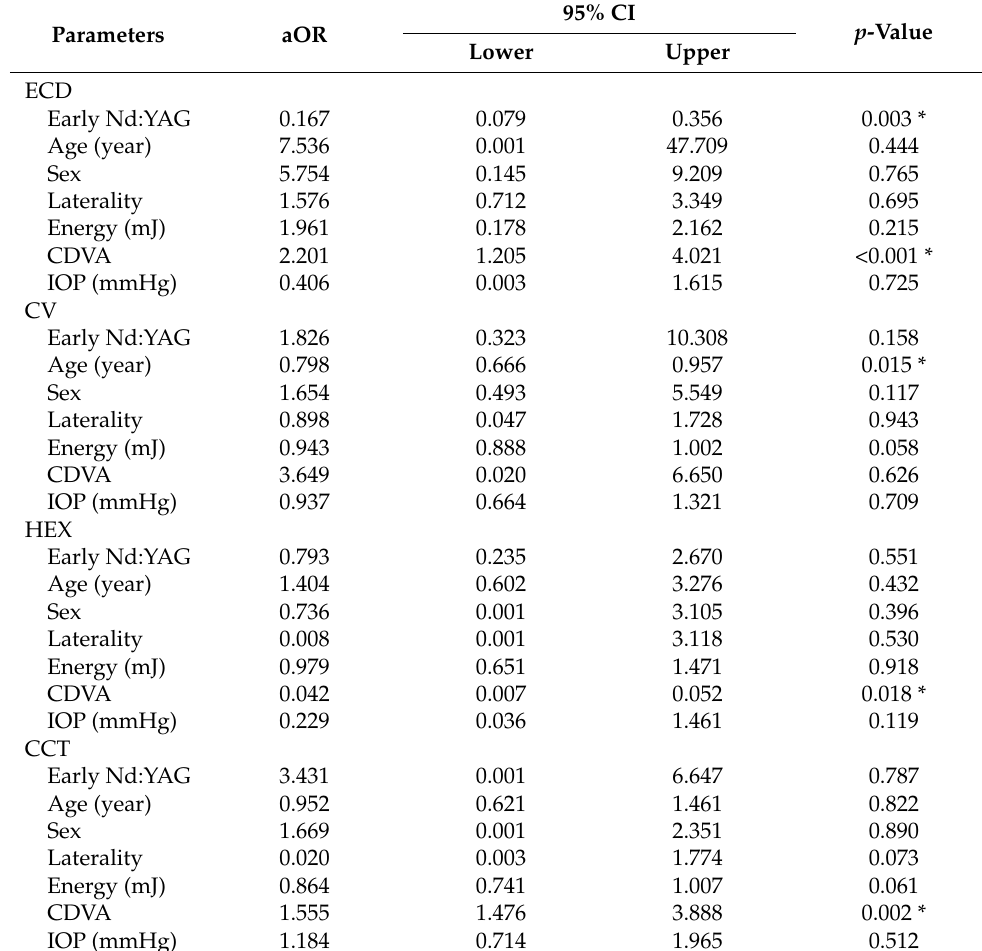
Table 3. The effect of timing of Nd:YAG on corneal endothelial